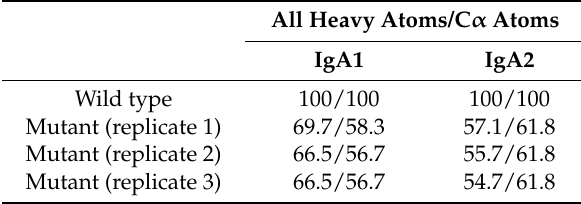
Table 2. Percentages * of native contacts (%) in the minimized structures of IgA1 and IgA2 mutants, showing the contact loss as compared to the wild type.